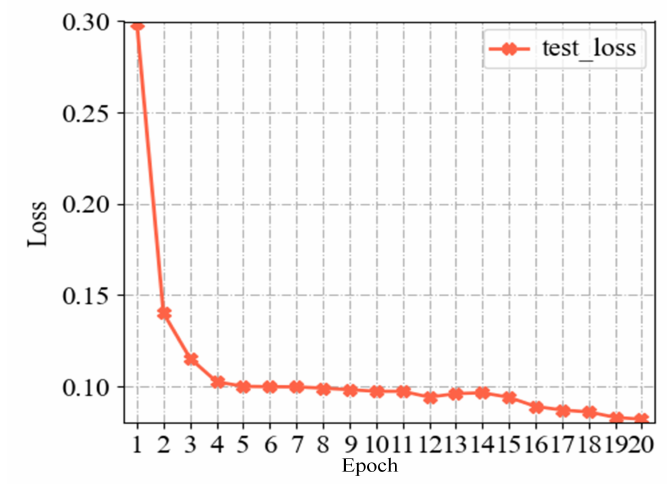
Figure 11. Loss value of test set.